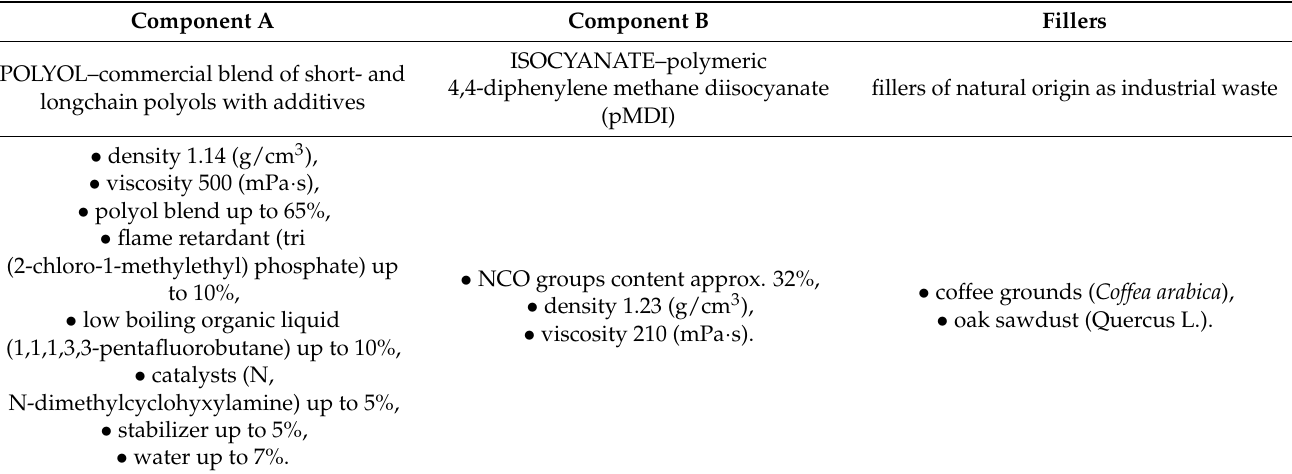
Table 1. Components used and their physicochemical